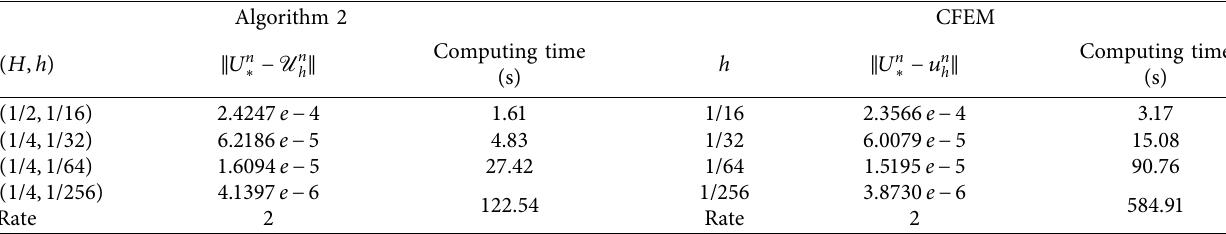
Figure 2: (a) Te exact solution u . (b) Te numerical solution U Table 3: Numerical results of Algorithm 2 and CFEM.